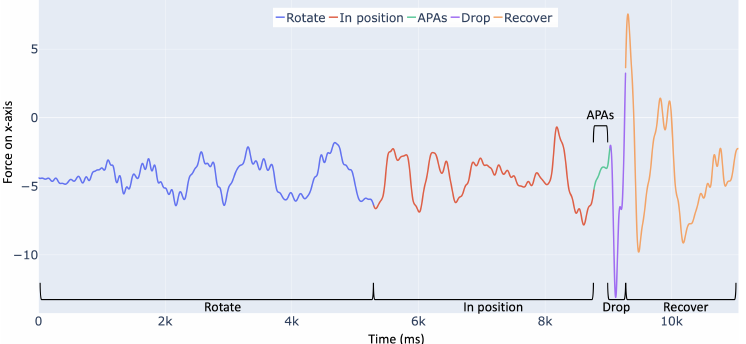
Figure 5. Overview of motor task phases: ( blue ) rotate, ( red ) in position, ( green ) APAs, ( purple ) drop, and ( yellow ) recover.